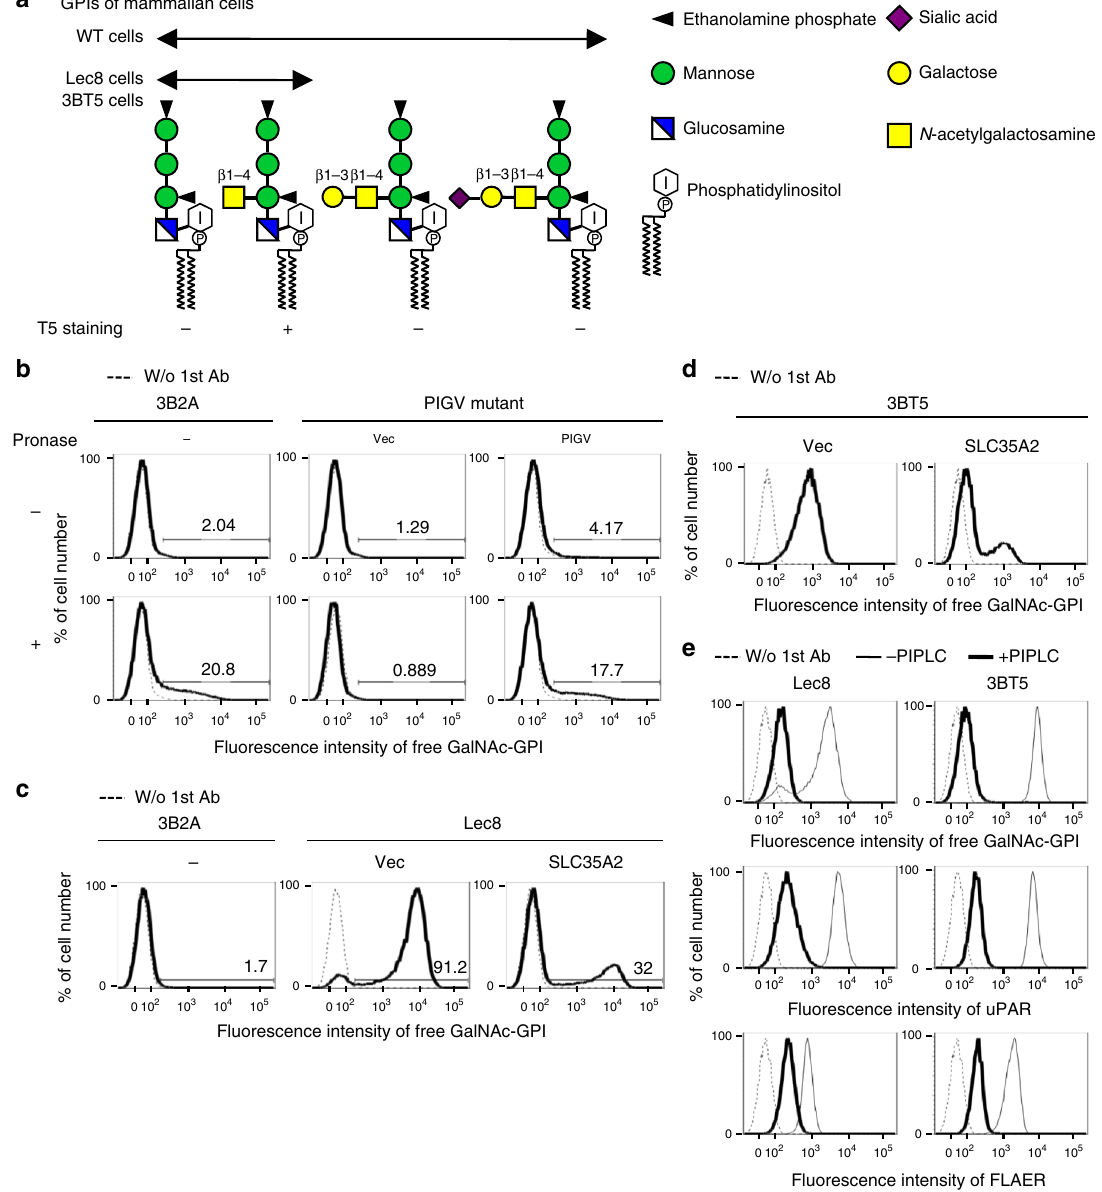
Fig. 1 Detection of GalNAc side-chain of mammalian free GPIs by T5 mAb. a GPI structures in wild-type (WT), Lec8 and 3BT5 CHO cells. − and +, T5 staining negative and positive, respectively. b 3B2A (WT) cells (left) and PIGV-mutant CHO cells transiently transfected with empty vector (center) or PIGV cDNA (right) were treated with (bottom) or without (top) pronase and then stained with T5 mAb and polyclonal second antibody. c Staining of Lec8 cells with T5 mAb. 3B2A (WT) cells and Lec8 cells transiently transfected with empty vector or SLC35A2 cDNA were stained with T5 mAb and second antibody. d Staining of 3BT5 cells transiently transfected with vector or SLC35A2 with T5 mAb and monoclonal second antibody. e GPI speci fi city of T5 mAb. Cells were stained with T5 mAb, anti-uPAR, or FLAER with or without PI-PLC treatment. b – e Experiments were repeated at least twice. Dotted lines, background staining without fi rst antibody. See also Supplementary Fig.